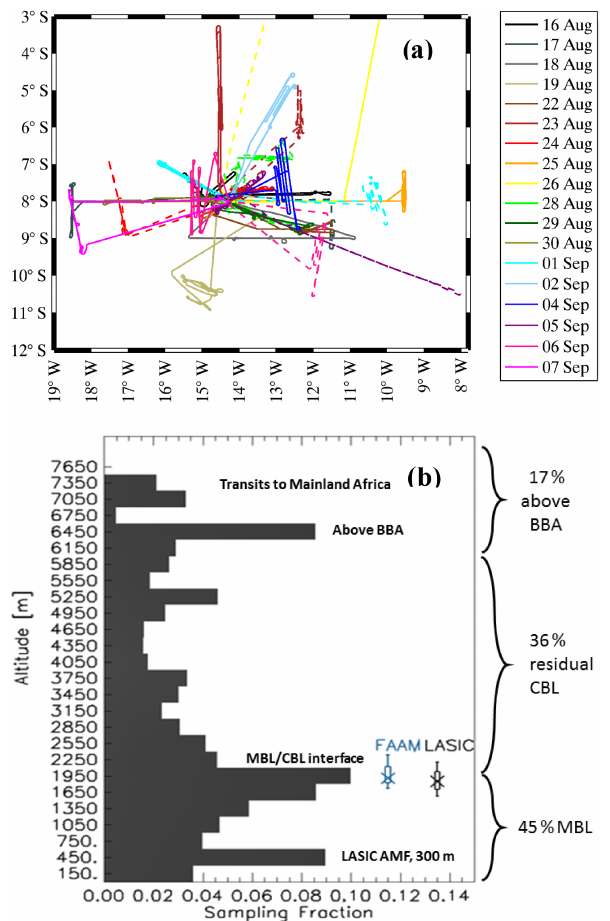
Figure 7. (a) Geographical position of the sorties that were per- formed during CLARIFY-2017 and (b) an analysis of the sampling altitudes during the campaign, with the boundary layer heights from FAAM and the LASIC AMF diagnosed during the campaign shown by the bar and